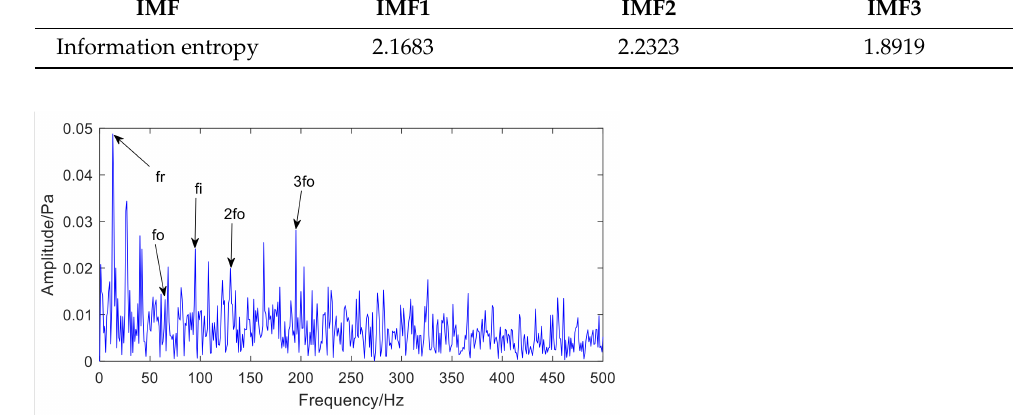
Figure 15. The envelope spectrum of the optimal component IMF3 selected by